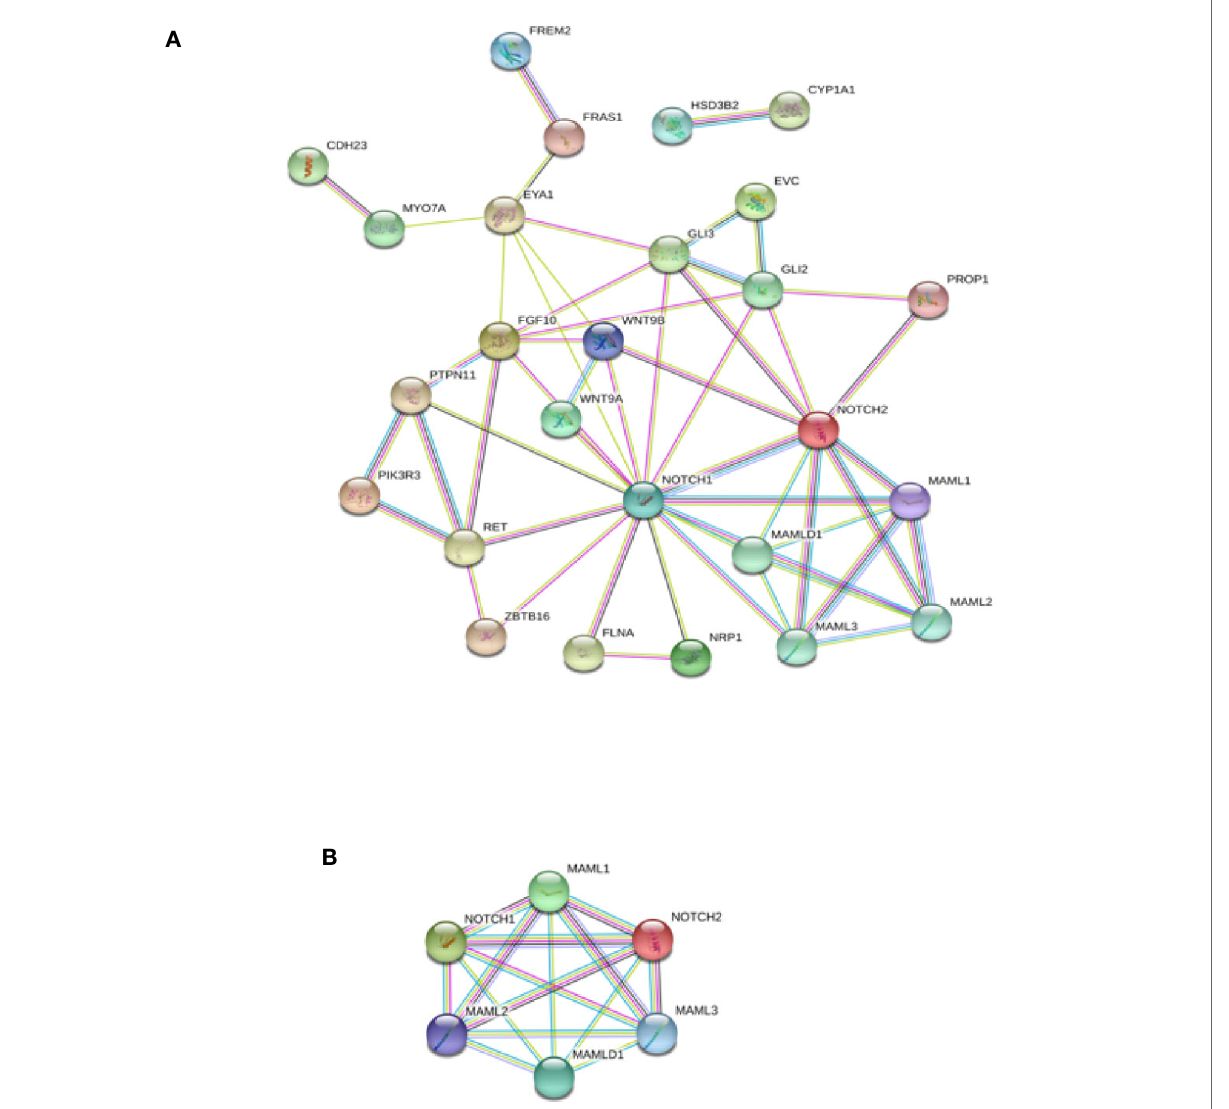
FIGURE 4 | Interaction network of DSD- and MAMLD1-related genes identi fi ed in DSD individuals harbouring genetic variants in MAMLD1 . (A) The scheme depicts an overview of detected genes and their interrelationship. (B) Core network of the detected genes and their interrelationship. Filled nodes show proteins with known or predicted 3D structure. Empty nodes depict proteins with unknown 3D structure. Candidate genes are underlined. Known interactions correspond to curated databases (turquoise lines) and experimentally determined interactions (pink lines). Predicted interactions correspond to gene neighbourhood (green lines), gene fusions (red lines) and gene co-occurrence (blue lines). Other interactions correspond to text mining (yellow lines), co-expression (black lines) and protein homology (violet